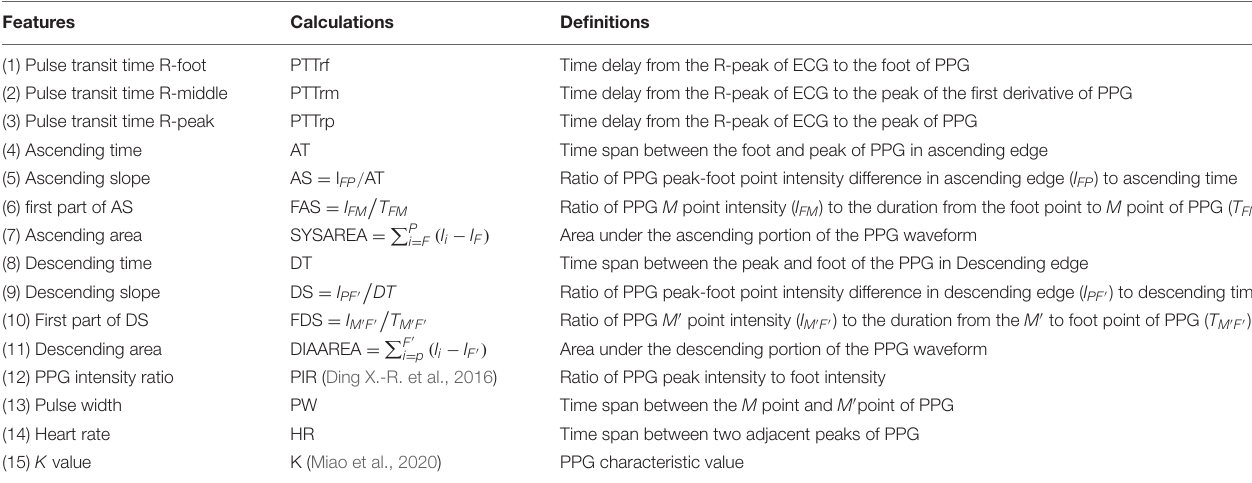
FIGURE 1 | (A) Experimental scene of simultaneous acquisition of ECG, PPG, and IBP signals. (B) Typical ECG, PPG, and IBP waveforms recorded in arrhythmias. The type of each beat is labeled in the ECG waveforms. The two adjacent beats in the IBP waveforms with the largest changes in SBP are marked in the red font. ECG, electrocardiogram; IBP, invasive blood pressure; PVC, premature ventricular contraction; PPG, photoplethysmogram; SR, sinus rhythm; SBP, systolic blood pressure. TABLE 1 | Definitions and calculation methods of the extracted